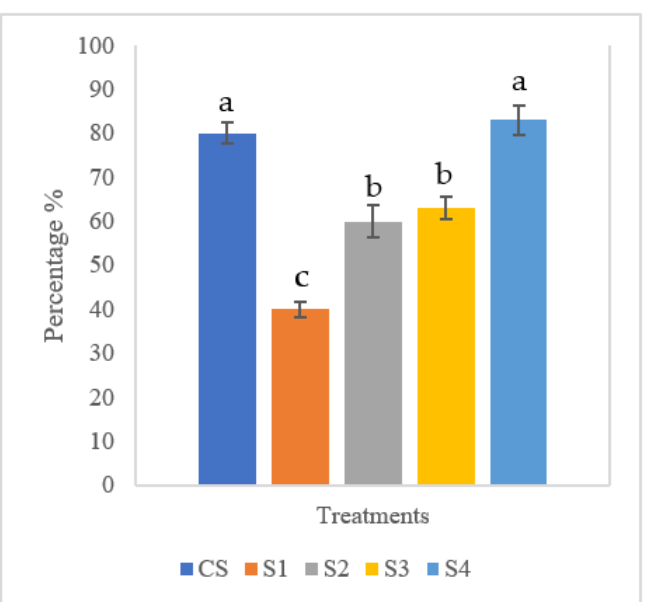
coccus agalactiae ), which was not significantly different ( p > 0.05) from the control group (CS, 80 ± 0.82%). The fish in the S4 group showed significantly higher survival when compared to the group with S. agalactiae only (S1, 40 ± 0.34%).